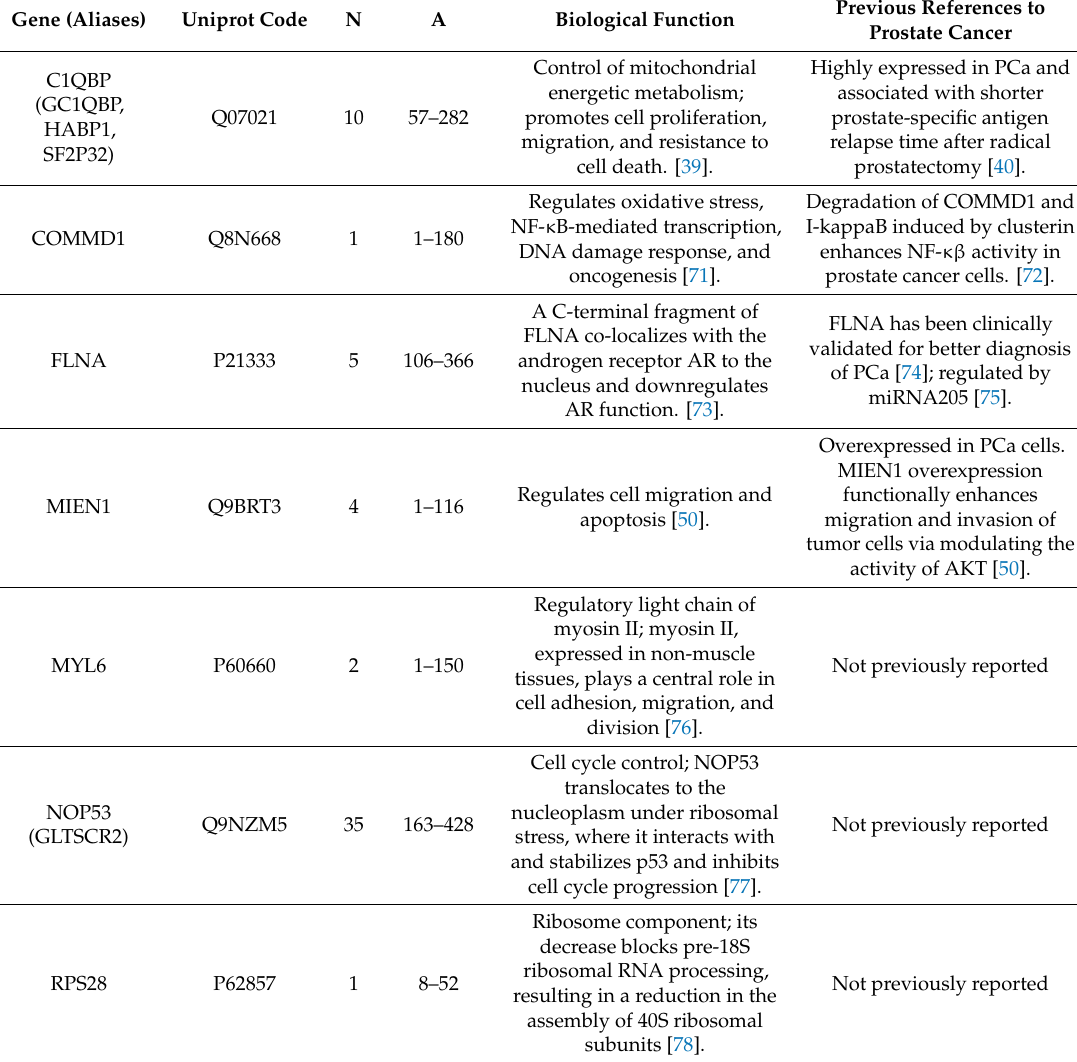
Table 4. Proteins identified in the HMGB2 Y2H interactome in primary tumor